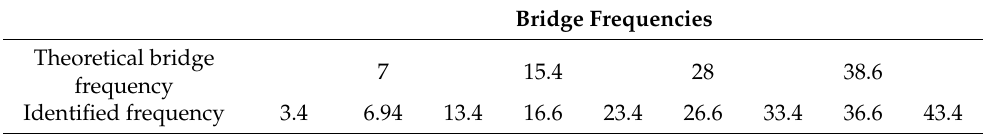
Figure 25. FFT of right rear axle acceleration history of the VBI model on the bridge with the generated road roughness. The comparison of identified results and reference bridge frequencies are listed in Table 11. Table 11. Comparison of identified bridge frequencies and the theoretical bridge frequencies (Hz).